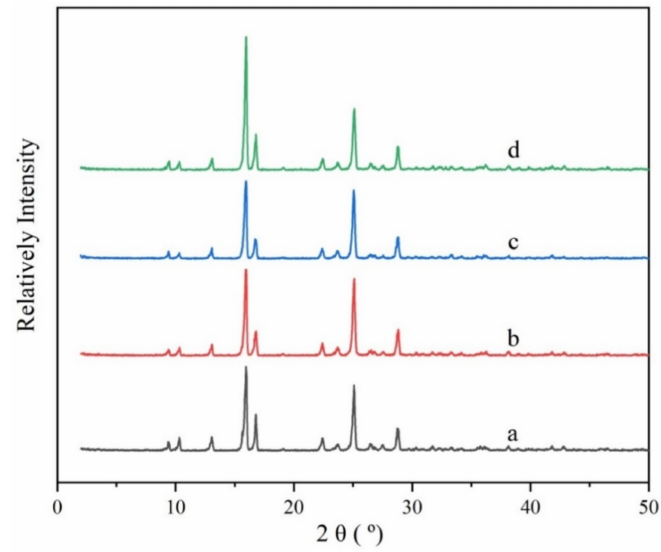
Figure 5. X-ray powder diffraction patterns of the PMBA solid samples. ( a ) is the raw material; ( b – d ) stands for the PXRD patterns of the samples obtained from solvent with ethanol mass fractions of 0.6, 0.8, and 1.0, respectively.